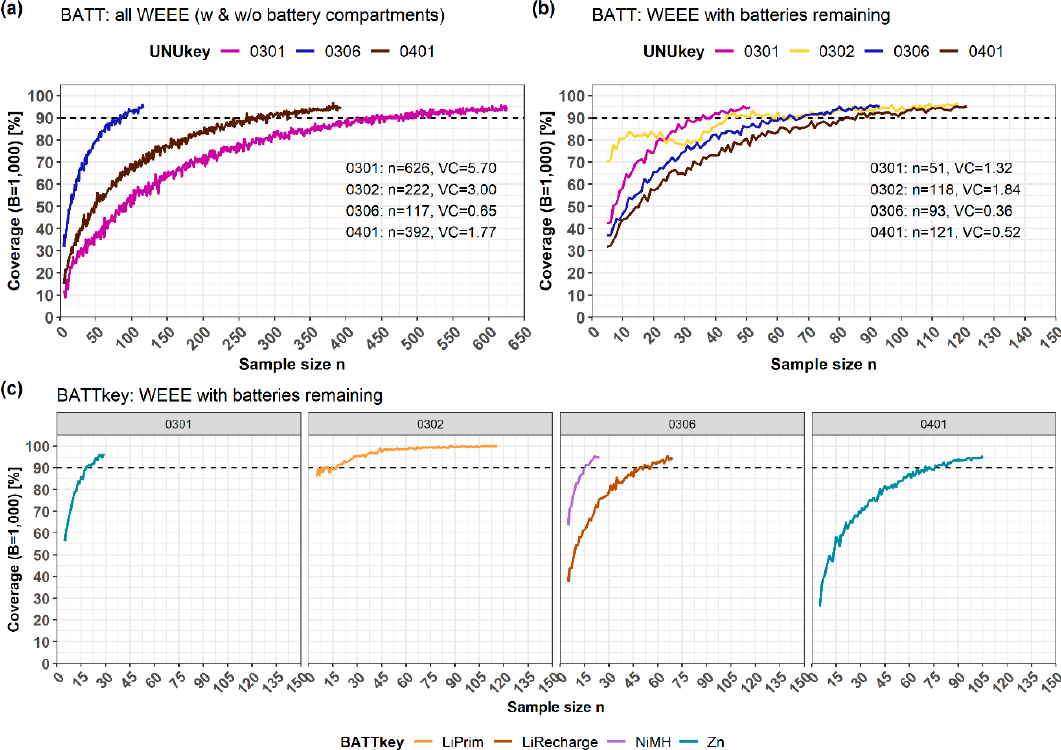
Figure 7. NPA: Simulation of MSS using bootstrap simulation. The proportion of sub-samples that lie within the simulated 95% CI* (coverage) is plotted against the number of samples used to draw the sub-samples. A coverage of 90% is considered acceptable to achieve representable results with the given sample size (dashed line). The graphs show the three possible combinations using small information technology (IT) (0301), desktop personal computers (PCs) (0302), mobile phones (0306) and small consumer electronics (0401) as examples: ( a ) all WEEE with and without battery compartment, ( b ) only WEEE with battery compartment without battery specification (BATT), ( c ) WEEE with batteries and BATTkey